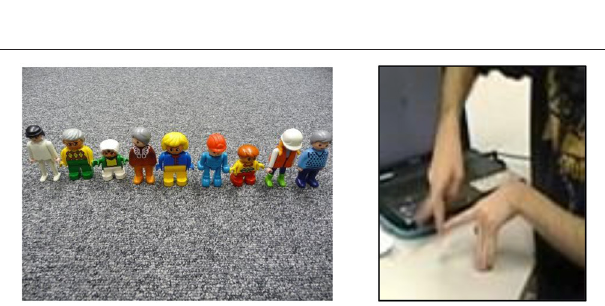
FIGURE 9 | This participant is using a novel handshape to gesture people standing in a row, using the index finger to represent the direction in which the people are facing and the middle, ring and baby fingers the